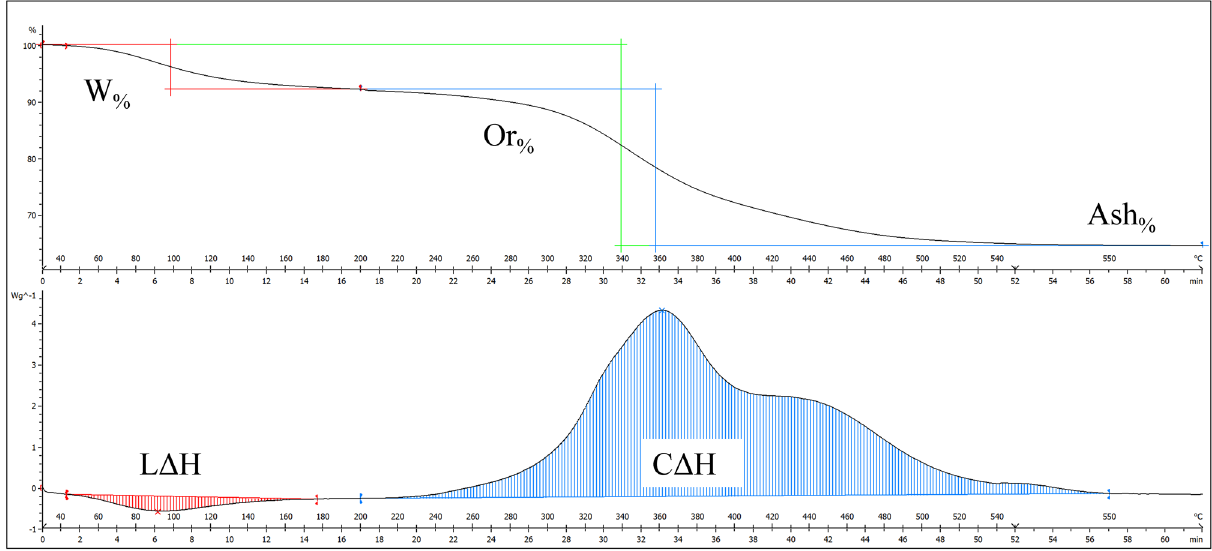
Figure 3. Graphic representation of thermal analysis experiment. Example of thermogravimetric ( A ) and differential scanning calorimetry ( B ) curves. The first weight loss represents the bone matrix dehydration and matches with the endothermic peak responsible for triple helix thermal denaturation (LΔH and W%). The second weight loss (Or%) represents organic combustion (CΔH) and matches the DSC curve. Subtracting the entire weight loss (Ash%) from 100, it is possible to obtain mineral